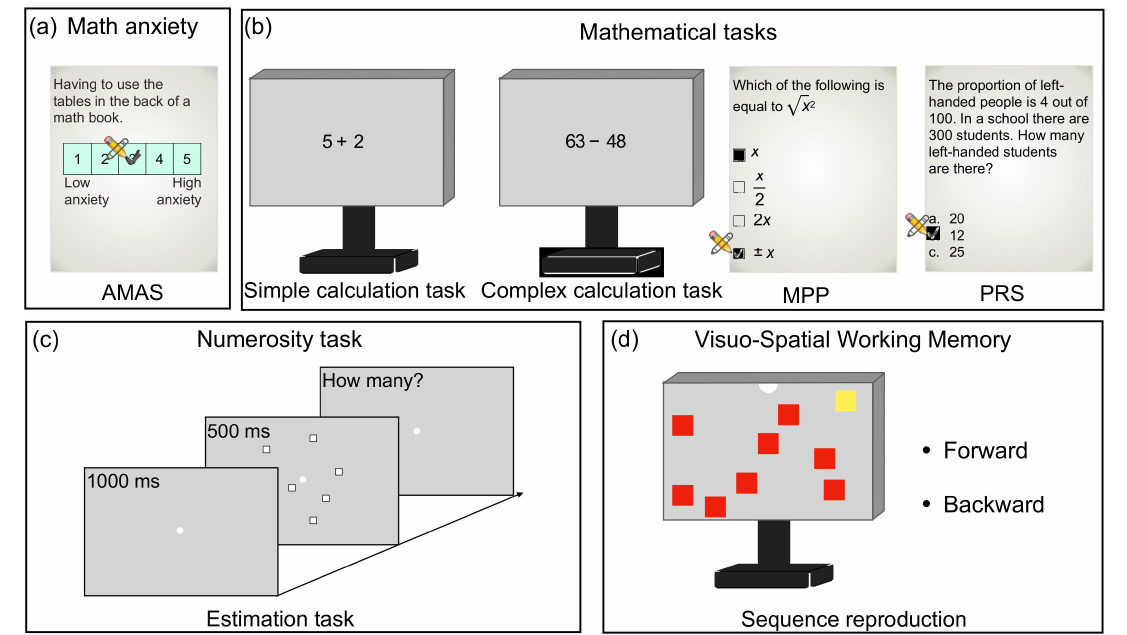
Figure 1. Illustration of task and stimuli. ( a ) Example of one item of the Abbreviated Math Anx- iety Scale. ( b ) Mathematical tasks. We measured participants’ math performance through two computerized tests (simple and complex calculation tasks) and two paper-and-pencil question- naires (Mathematics Prerequisites for Psychometrics—MPP, and Probabilistic Reasoning Scale—PRS). ( c ) Illustration of the numerosity estimation task. ( d ) VSWM was assessed by a computerized task. Participants observed the sequence of squares turning to yellow and then repeated the sequence in the same (forward condition) or reverse (backward condition)